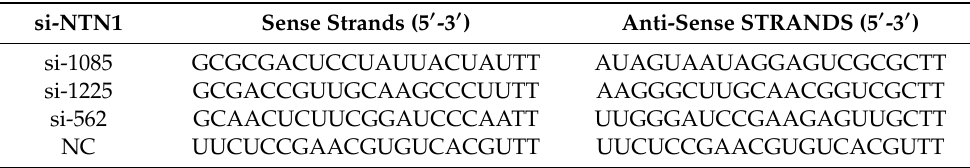
Table 2. si-RNA targeting the mouse NTN1 coding